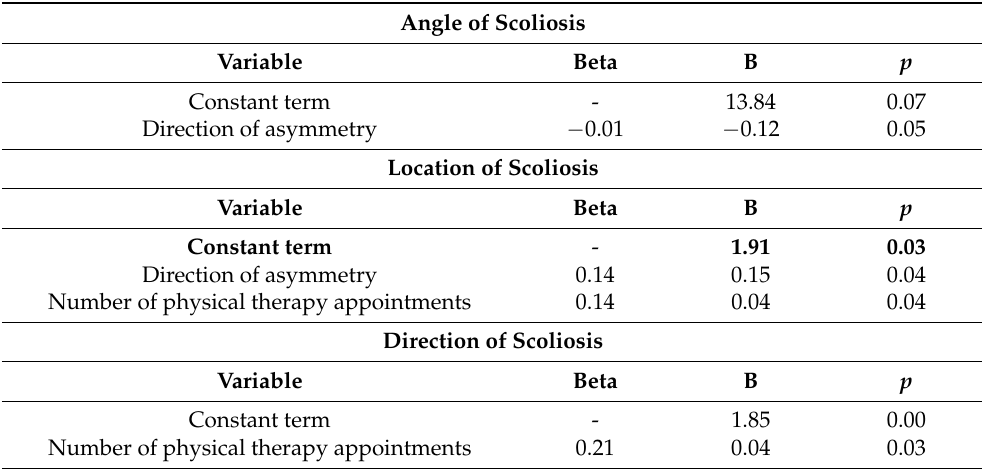
Table 6. Results of regression analysis for the variables: scoliosis angle as well as the location and direction of curvature in the study group